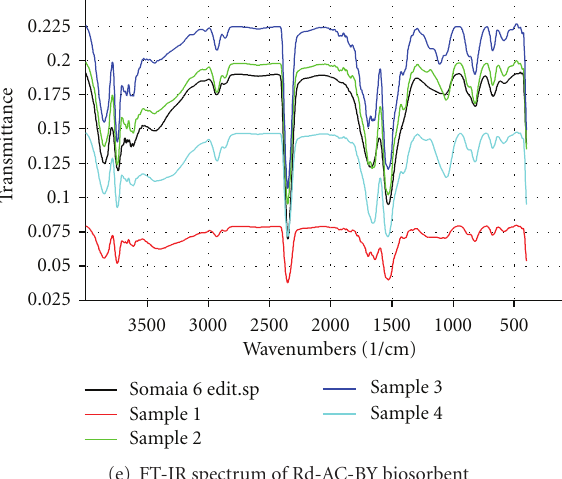
Figure 1: FT-IR spectra of various chemically and biologically treated carbonaceous